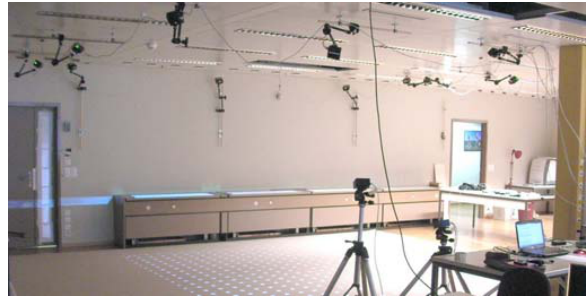
Figure 4. The user is seated in the haptic workstation (left); both the arms and the fingers can be guided by force feedback when manipulating an object (right). Physically-based interactions [14] exploit PhysX from Nvidia.